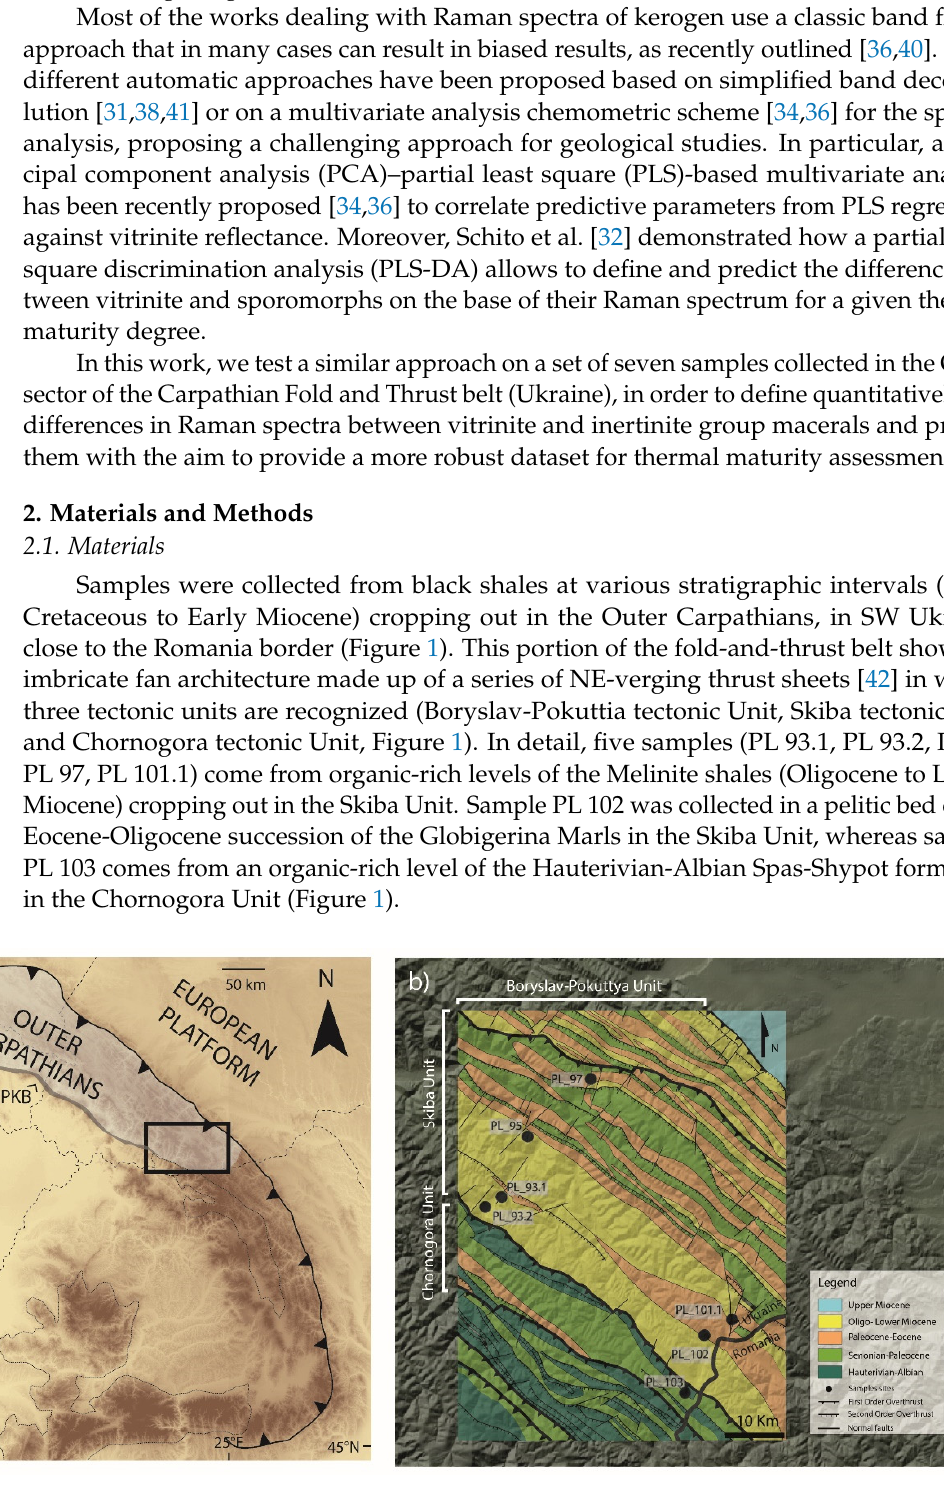
Figure 1. Geographic and geologic setting of the studied area: ( a ) Simplified tectonic sketch of the Carpathians, in the square the b map location. PKB: Pieniny Klippen Belt. ( b ) Geological map of the sampled area. Black dots indicate sampled sites. Redrawn from the “Geological map of the outer Carpathians: borderland of Ukraine and Romania. 1:200,000” [43] .